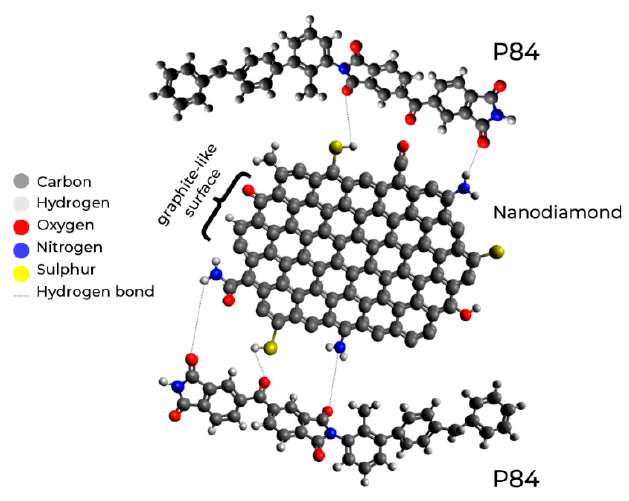
Figure 1. Structure of nanodiamonds and P84 copolyimide.